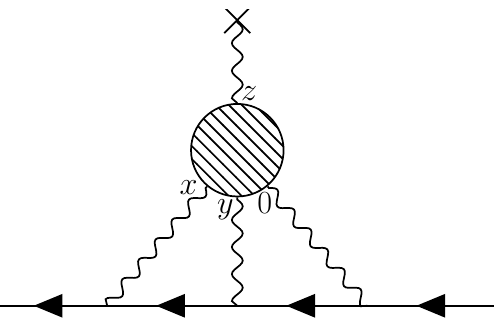
Figure 2 . Hadronic light-by-light scattering diagram in the muon ( g − 2) with the locations of the vertices x, y, z, 0 in the master formula in eq.